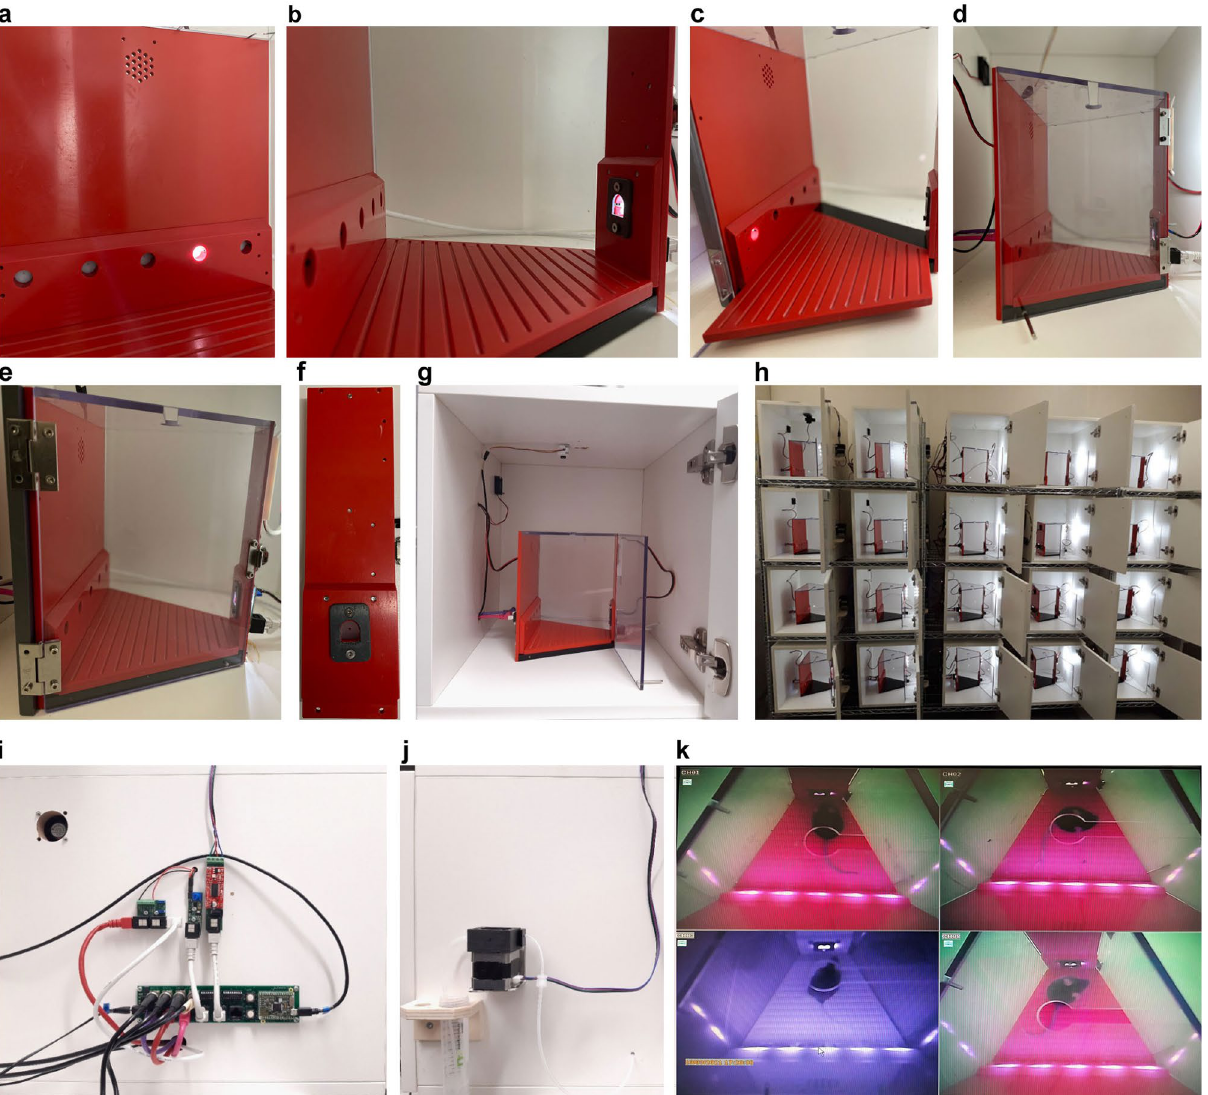
Figure 3. Design of inner and outer box. ( a ) 5-choice wall with one poke-hole illuminated. Note perforation at top for speaker. ( b ) 5-choice (wall) and receptacle (right) wall, showing protruding design of poke panel with angled finish at top and elevated position of poke holes; receptacle poke illuminated. ( c ) Easily washable, sliding floor with groves for fast turn-over of subjects between runs. ( d,e ) Side view of complete operant box with two different door designs: door opening on the left and fixed in place by a magnet at its bottom that also constitutes the door handle (d) , or door opening on the right and fixed by snap-lock (e) . ( f ) Frontal view on isolated receptacle wall with grey frontal spacer layer (2 mm thickness) that shields break-beam. ( g ) Operant box within outer sound-attenuating cubicle, including all cabling required for operation. ( h ) Set-up of 20 stacked operant boxes within their cubicles, house-lights illuminated. ( i,j ) Left ( i ) and right ( j ) outer side walls of the cubicle with mounted PCBs on the left (compare cabling to Fig. 1a) and peristaltic pump and reward container on the right. ( k ) Visual monitoring of animal behaviour through low-cost CCTV cameras and a 16-channel CCTV system (only 4 boxes shown). Boxes that are currently not illuminated due to time-outs are video-recorded via infrared and hence appear in